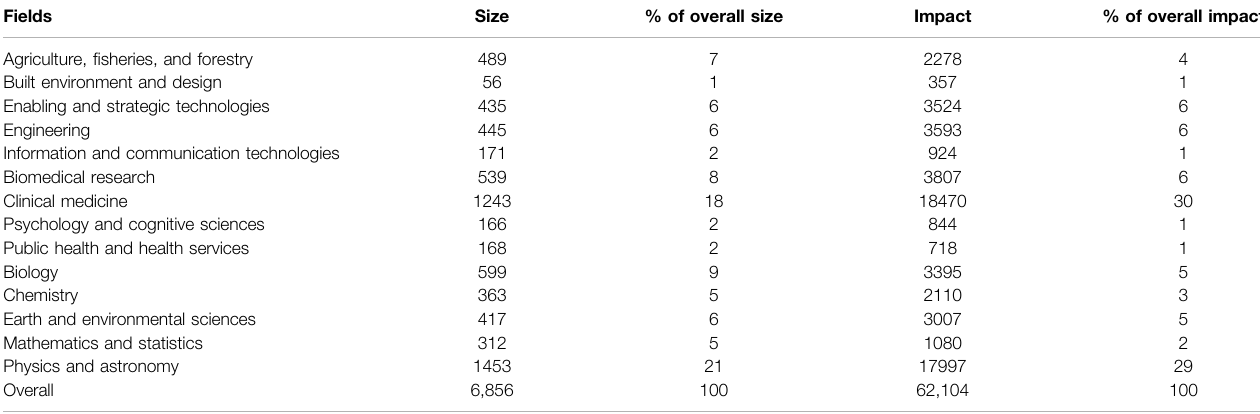
TABLE 2 | The Chilean science system size and impact, at the fi eld level, in